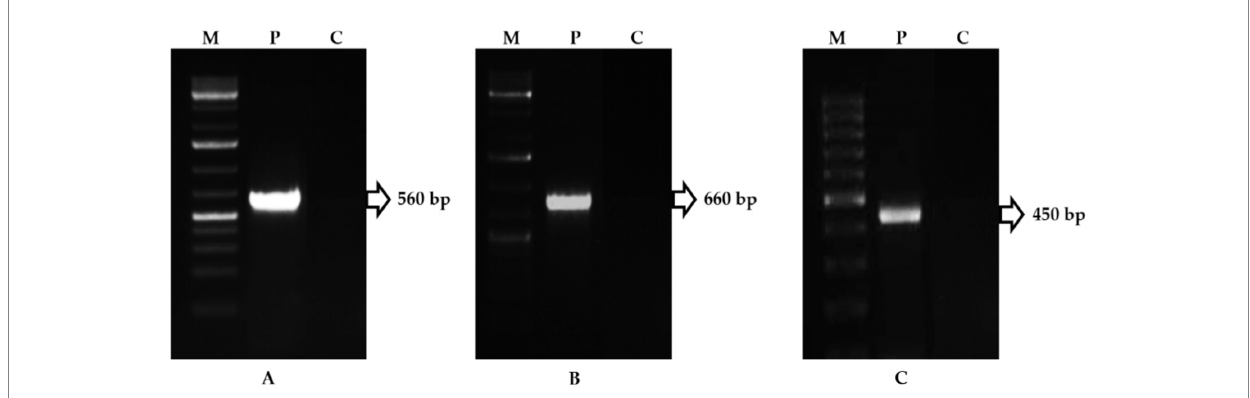
FIGURE 3 PCR amplification of Fusarium oxysporum f. sp. lycopersici genome (M-Marker, P-Pathogen, C-Control). (A) Amplicon of ITS1/ITS4 primers; (B) Amplicon of F. oxysporum -specific primers; (C) Amplicon of F. oxysporum -race-specific primers.